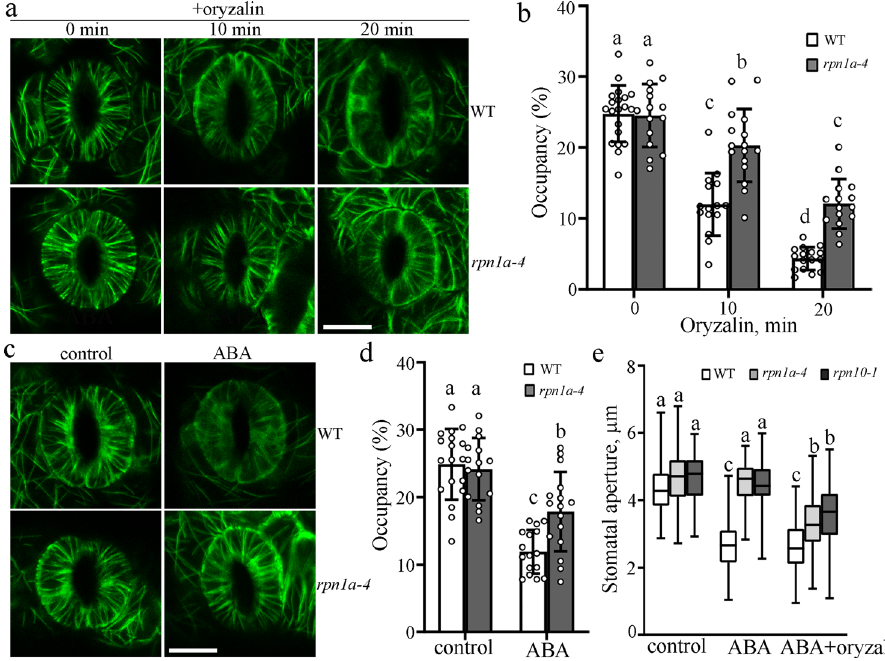
Fig. 1 Cortical microtubules in 26S proteasome mutant plants are insensitive to ABA-induced disassembly. a Cortical microtubules in guard cells from WT and rpn1a-4 seedlings treated with 5 μ M oryzalin for the indicated times. Scale bar = 10 μ m. b The graph shows the densities of microtubules in a . Data represent mean ± standard deviation (SD) values from three independent experiments with a minimum of 15 cells each. c Cortical microtubules in guard cells from WT and rpn1a-4 seedlings treated with 10 μ M ABA for 40 min. Scale bar = 10 μ m. d The graph shows the densities of microtubules in c . Data represent mean ± standard deviation (SD) values from three independent experiments with a minimum of 15 cells each. e Detached rosette leaves from WT, rpn1a-4 , and rpn10-1 were incubated in opening buffer for 2 h and then treated with 10 μ M ABA plus 0 or 5 μ M oryzalin for 2 h. The box and whiskers plots represent minimum and maximum values. The line in the box indicates the median value and the boundaries demonstrate the 25th percentile (upper) and the 75th percentile (lower). Different letters represent signi fi cant differences at p < 0.01 (one-way ANOVA). The experiment was repeated three times as different biological replicates with a minimum of 100 stomatal